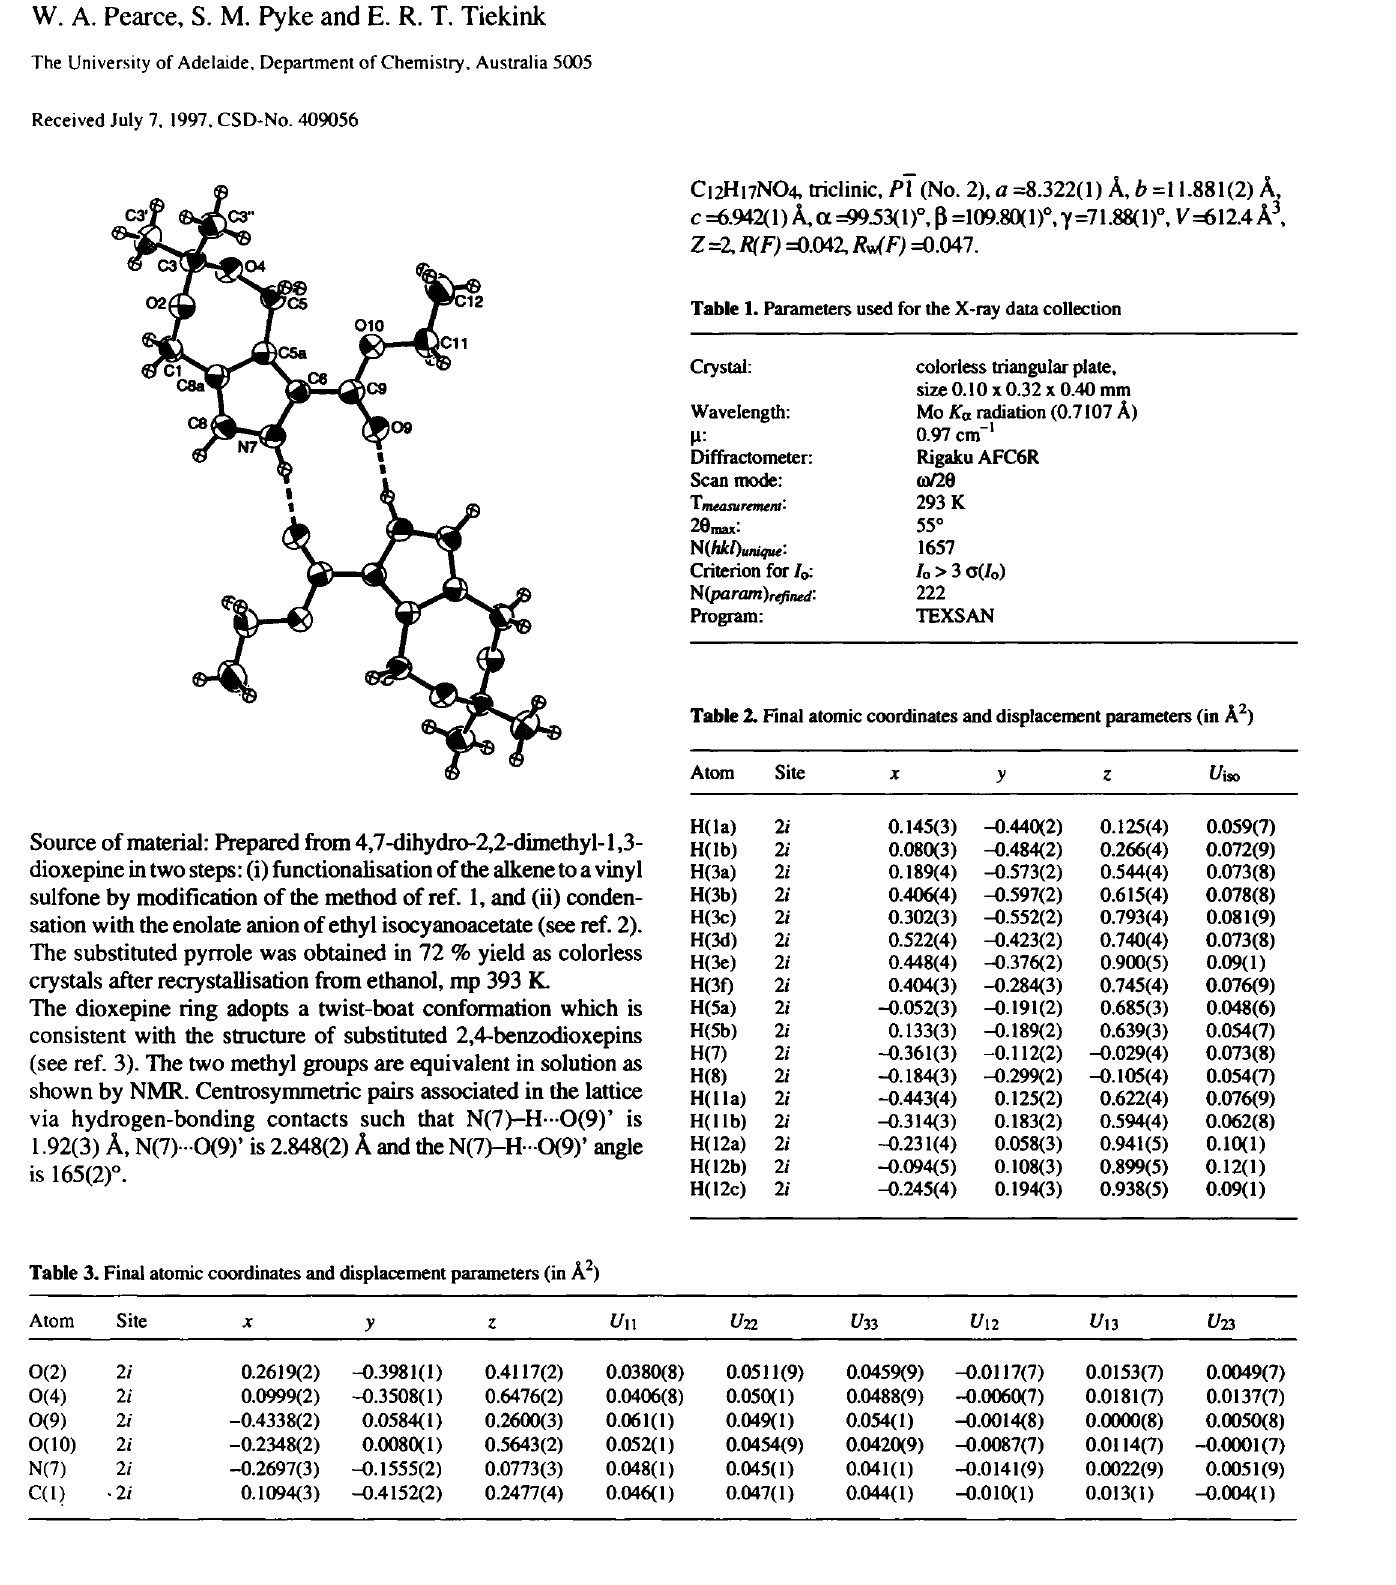
Table 1. Parameters used for the X-ray data collection Crystal: